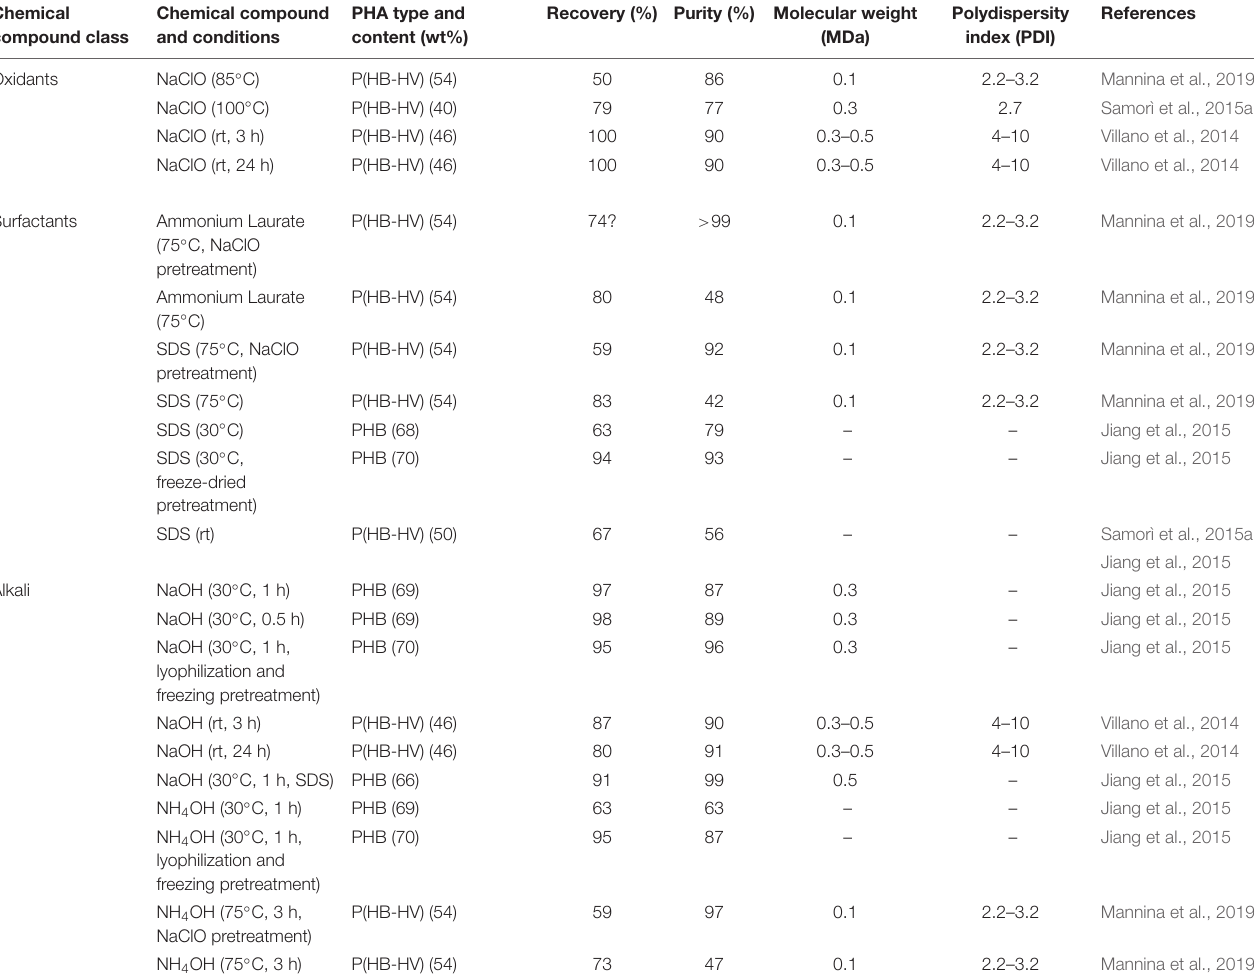
TABLE 5 | PHAs extraction from mixed microbial cultures through cellular lysis assisted by